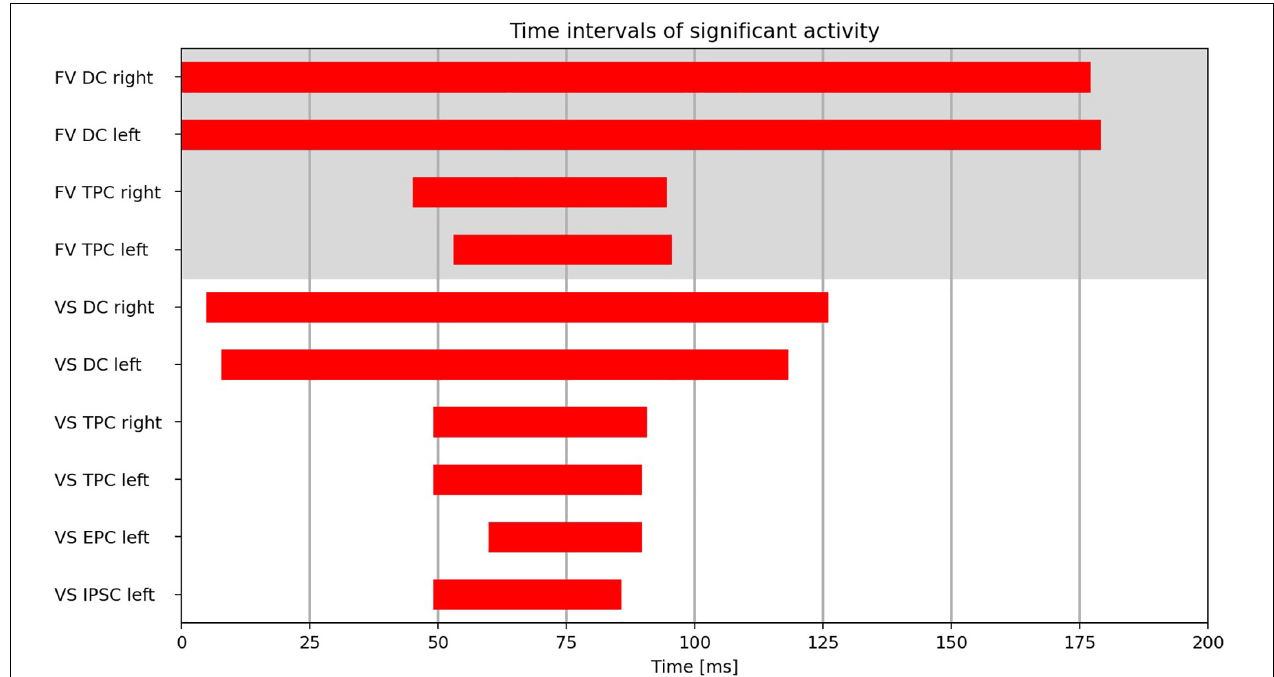
FIGURE 4 | Time intervals with significant activity in the cluster regions (DC, dorsal cluster; TPC, temporoparietal cluster; IPSC, intraparietal sulcus cluster; EPC, entorhinal-parahippocampal cluster) during FV and VS with fixation onset at t = 0 ms.